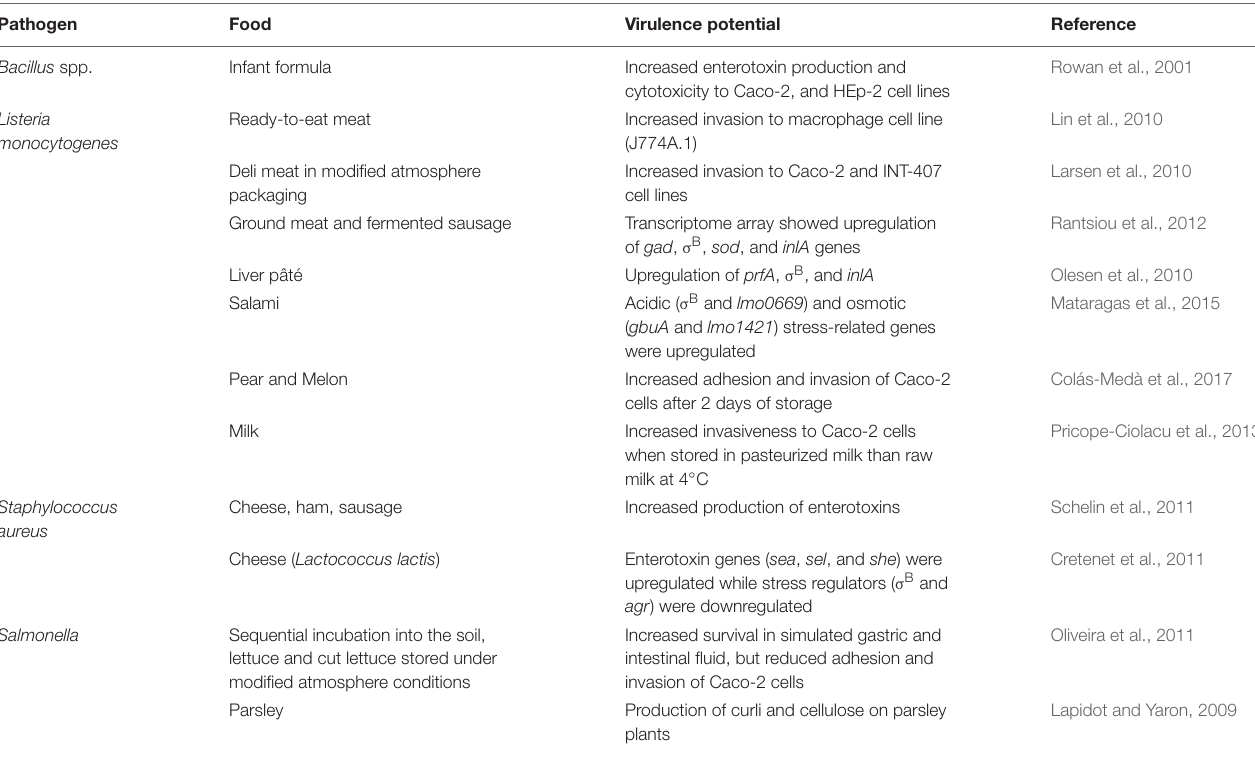
TABLE 2 | Effect of food products on virulence potential of foodborne pathogens.